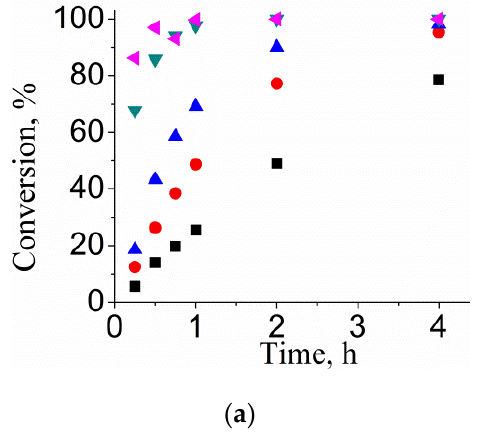
Figure 5. The temperature influence on the FAME conversion ( a ) and epoxide selectivity ( b ). Reac- tion conditions: FAME content of 1 wt%; catalyst content of 15 g·L − 1 ; unsaturated FAME:H 2 O 2 mo- lar ratio of 1:8; and temperature of 30 °C ( ), 40 °C ( ), 50 °C ( ), 60 °C ( ) and 70 °C ( ).